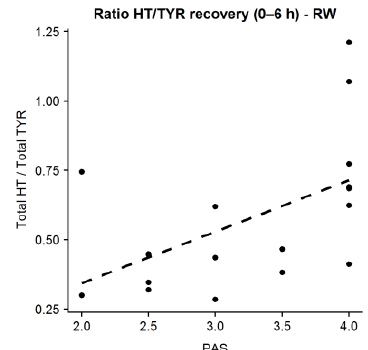
Figure 3. Correlation between polygenic activity score (PAS) and ratio HT:TYR of urinary recoveries (0 – 6 h) after red wine (RW) consumption.